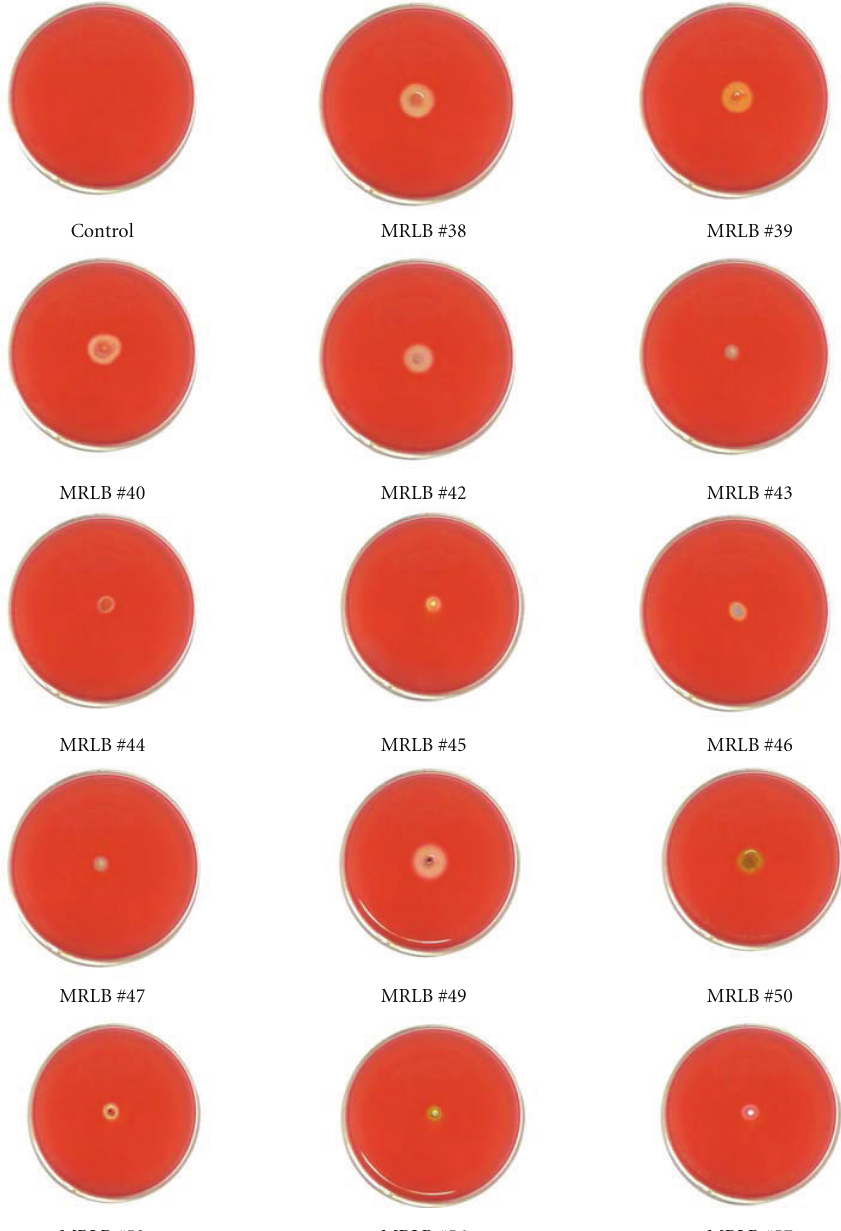
Figure 3: Primary screening of bacteria isolated from di ff erent